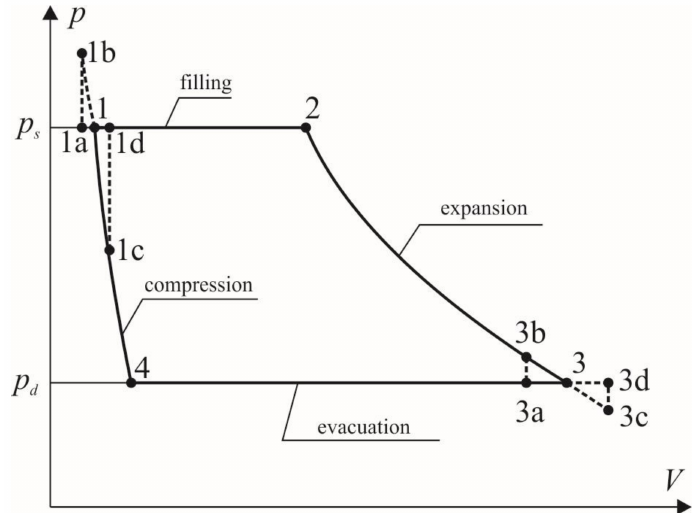
Figure 7. The multi-vane expander indicator diagram.